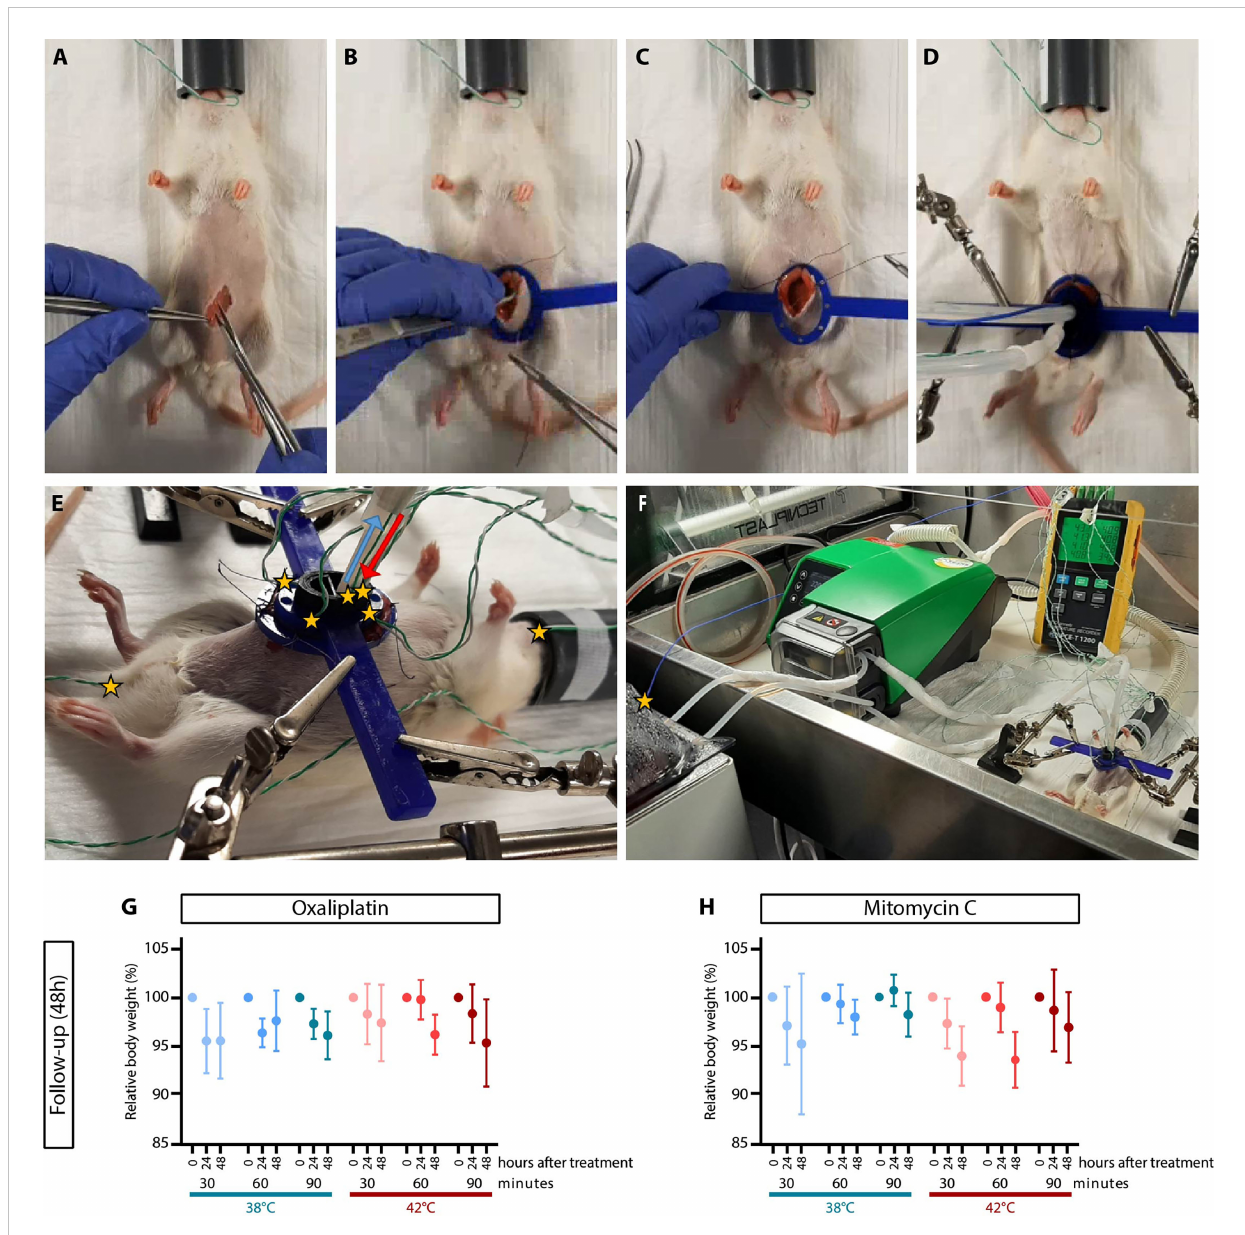
FIGURE 2 HIPEC treatments in rats did not affect body weight. To allow access to the peritoneum, a small incision was made (A) and the abdominal wall was attached to a plastic retractor ring with sutures (B, C) , enabling the placement the semi-open in/out fl ow HIPEC construction (D) . Temperatures probes were placed in the esophagus, in fl ow (red), out fl ow (blue), each of the four quadrants, rectum (E) and in the stock solution (F) . Temperature spots were indicated by yellow stars. The average body weight immediately after, 24 hours and 48 hours after HIPEC with oxaliplatin (G) and mitomycin-C (H) is shown for a non-heated treatment procedure (38°C) and a heated treatment procedure (42°C). Means ± SD of 4-5 animals were